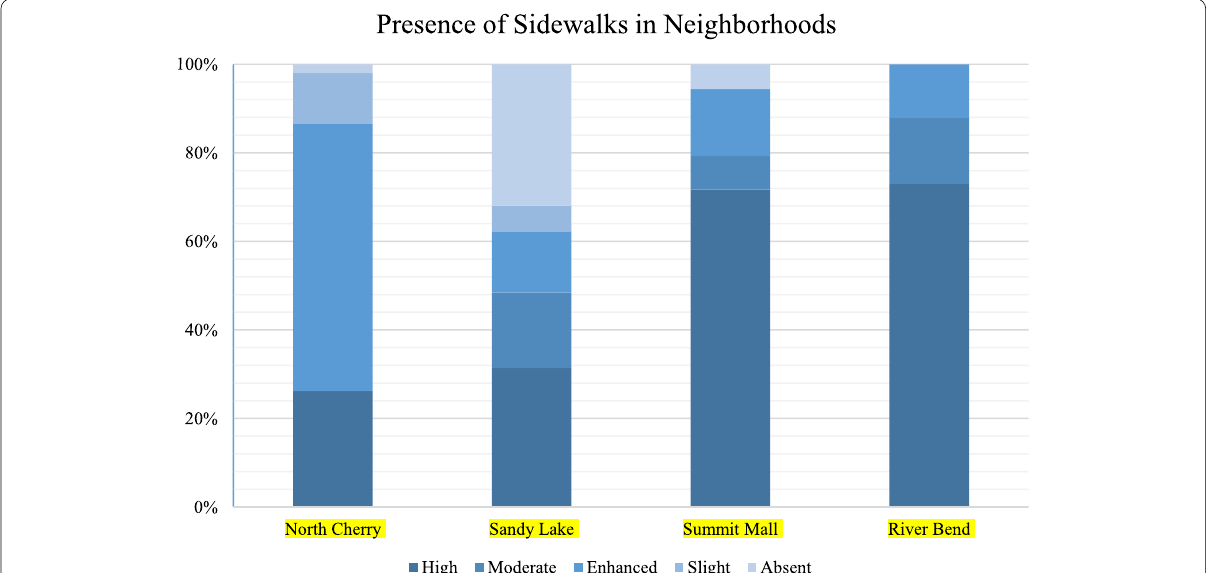
Fig. 8 Percentage of sidewalks. Description of the sidewalk classes: a high, denoting two-sided sidewalks the whole way; b denoting a street segment with two-sided and one-sided sidewalks; c enhanced, denoting three variations in a street segment: two sides, one side, and no sidewalks; d slight, denoting a segment with one side and no sidewalks; and e absent, denoting no sidewalks in the entire